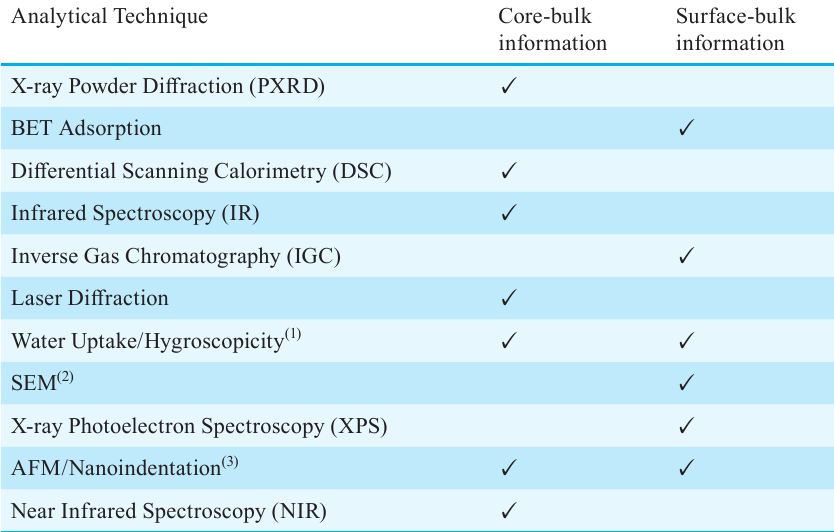
Table 1 Analytical methods frequently used for the physical characterization of